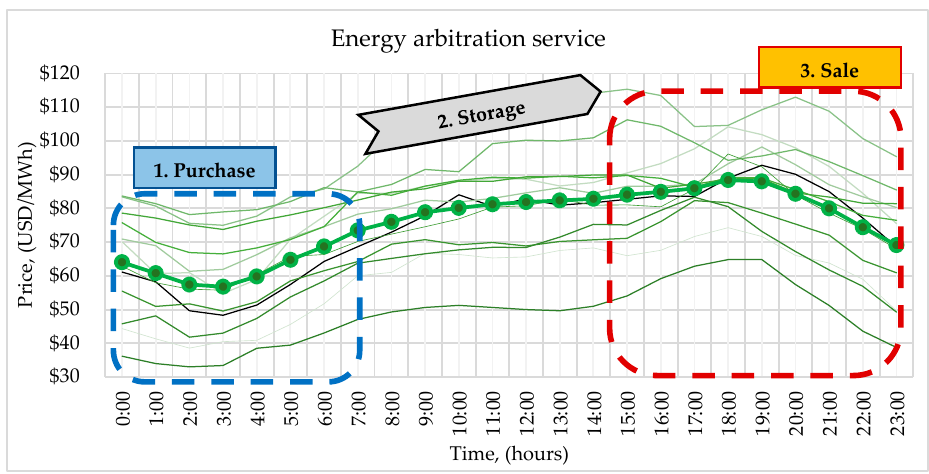
Figure 3. Scheme of energy arbitration service . Own source with CENACE data, 2021.